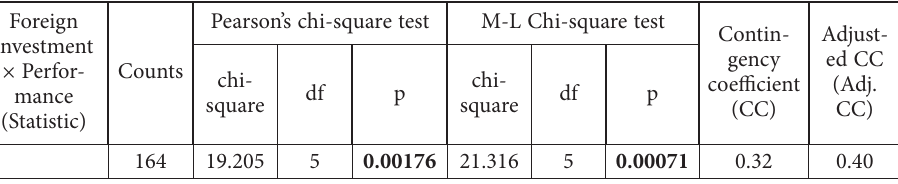
Table 4. Contingency: foreign ownership × performance – frequencies (source: own) Foreign